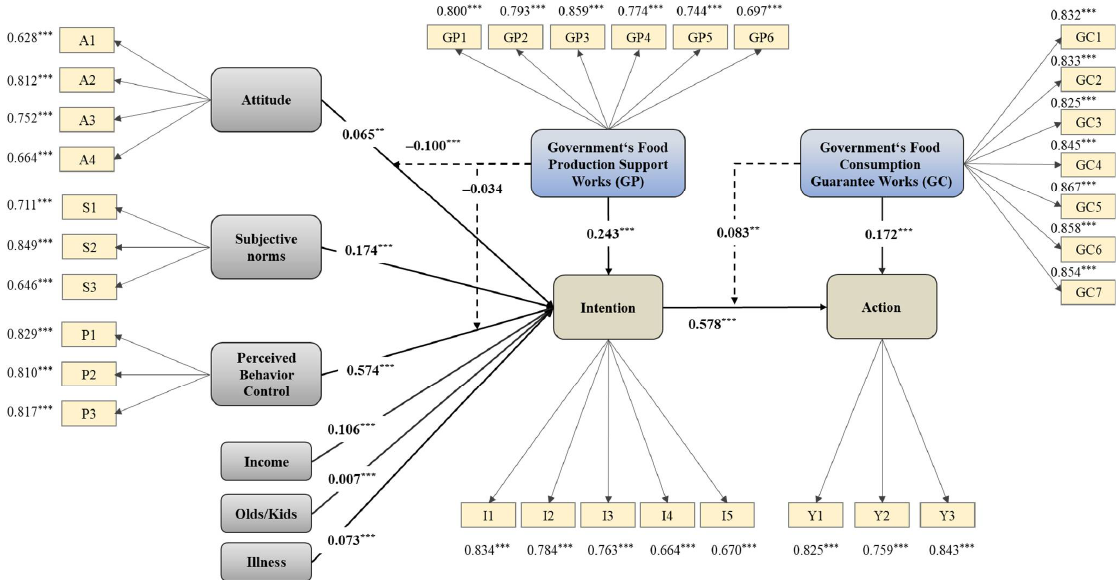
Figure 2. Structural model with path coefficients and levels of significance. *** p < 0.01. ** p < 0.05. Table 5. Path influence coefficient and significance.